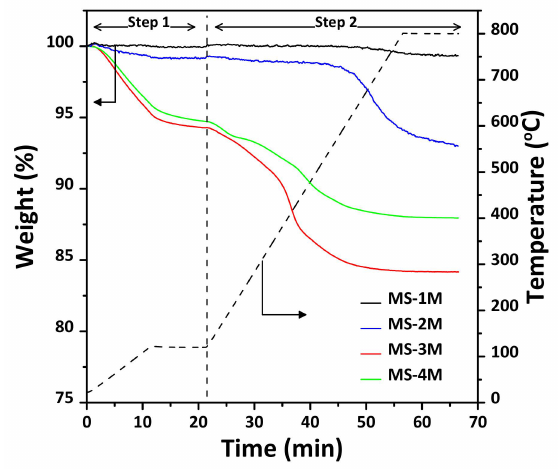
Figure 6. TGA profiles for the MS synthesized by using varying NaOH concentrations. Normalized weight of the mesoporous silica and TGA temperature (black dash line) as a function of TGA heating time. The first step (Step 1) removes the physically adsorbed water. The surface Si-OH density and content (i.e., chemisorption water) is based on the weight loss of Step 2.